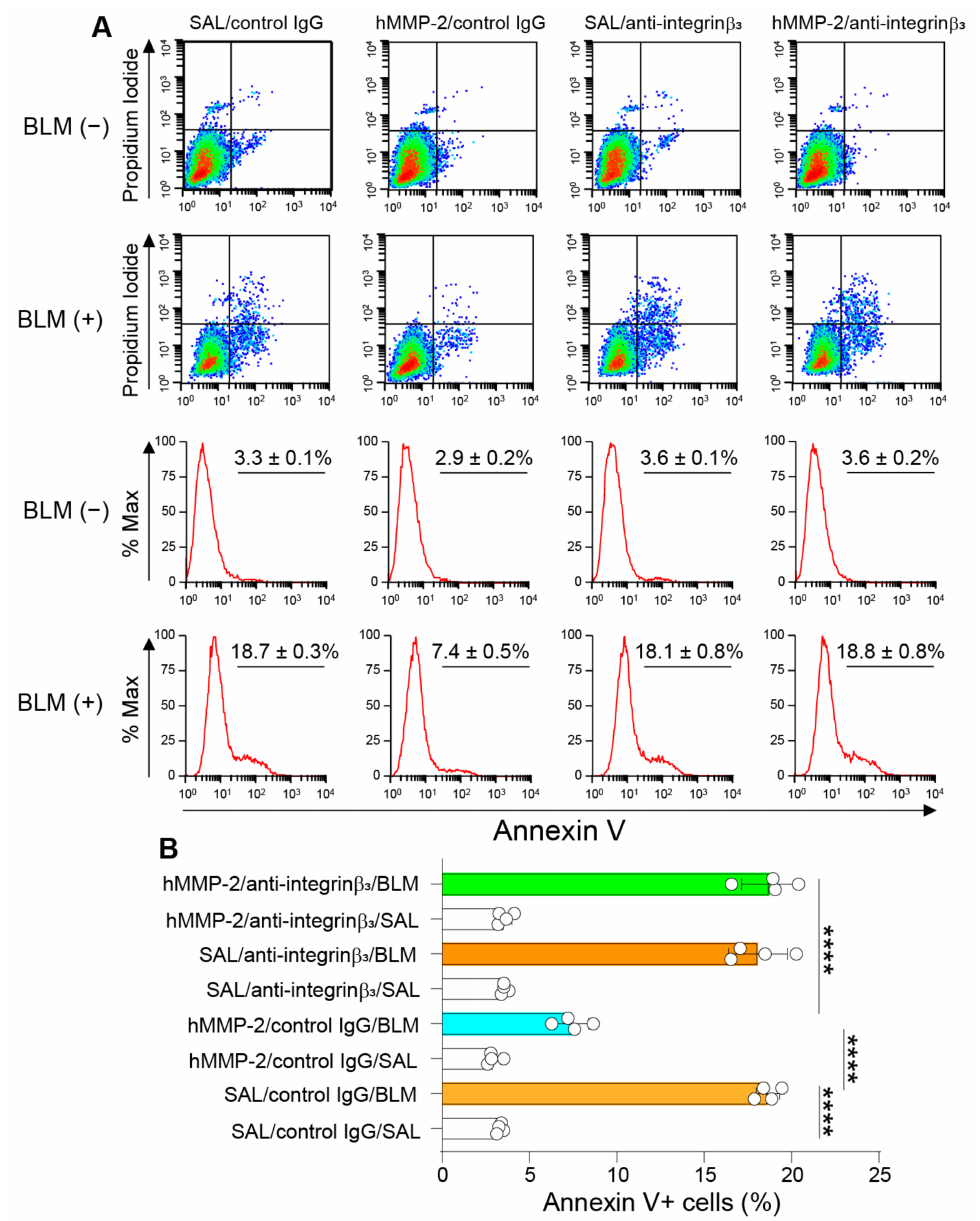
Figure 10. Anti-integrin- β 3 antibody blocks the anti-apoptotic activity of hMMP-2 in lung epithelial cells. A549 cells were pretreated with 5 µ g/mL of anti-integrin- β 3 or control IgG for 30 min before adding 0.5 µ g/mL hMMP-2. The cells were then treated with BLM (50 mU/mL) or saline and cultured for 24 h, and the number of apoptotic cells was evaluated by flow cytometry ( A , B ). Data are the mean ± S.D. Statistical analysis by ANOVA with Newman-Keuls test. **** p < 0.0001; hMMP-2, human matrix metalloproteinase-2; SAL, saline; BLM,